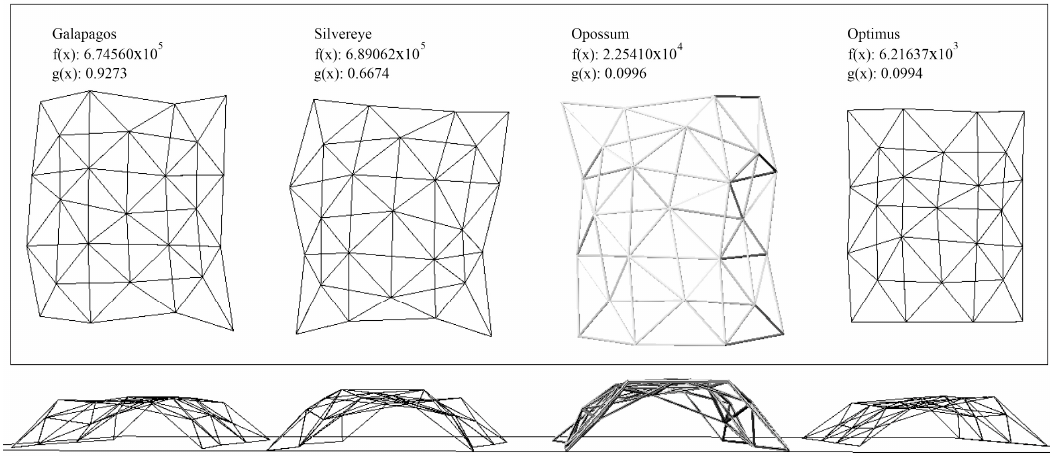
Figure 14. Optimized results of design problem.